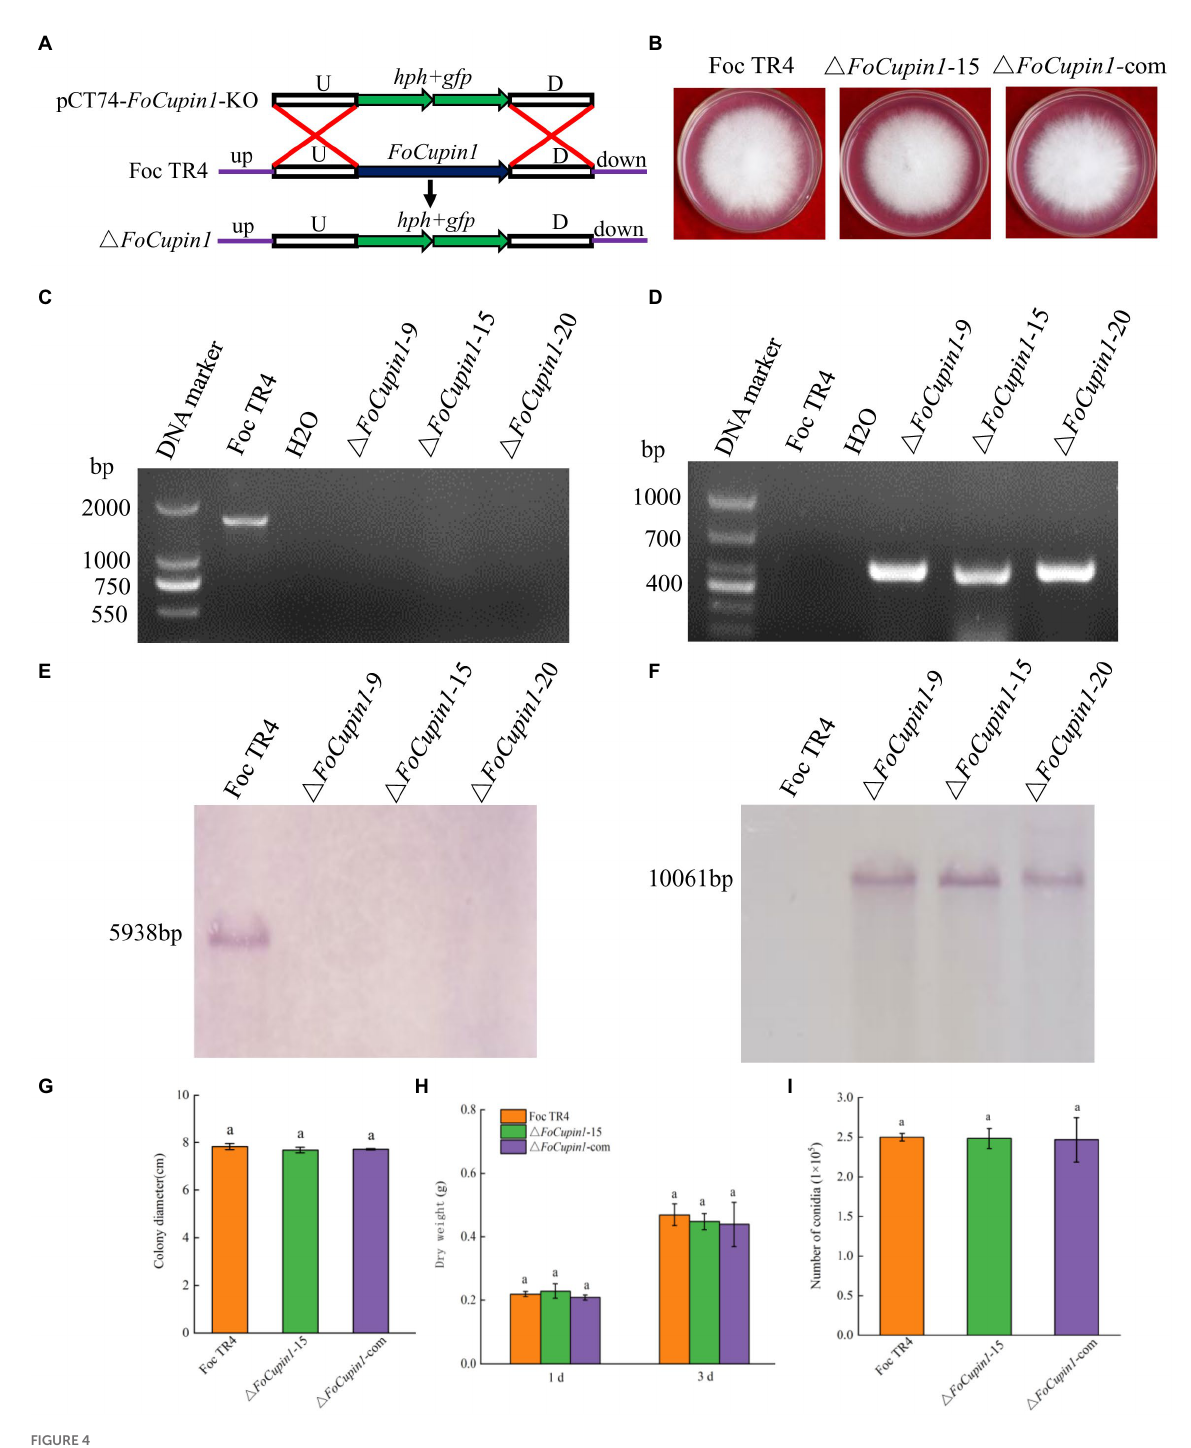
FIGURE 4 Construction, confirmation, and characterization of FoCupin1 deletion and complementation mutants. (A) Schematic strategy used for generation of the deletion mutant according to homologous recombination. U, upstream flanking region of FoCupin1 ; D, downstream flanking region of FoCupin1 . (B) Colony morphologies on PDA medium. Photos were taken 5 days after incubation. (C,D) PCR confirmation using FoCupin1 and hph as probes; (E,F) Southern blot validation using FoCupin1 and hph as probes, respectively. (G) Colony diameter. (H) Dry weight. Hyphae were collected from 1 and 3 days cultures grown in CM medium. (I) Conidiation. Foc TR4, the wide-type strain; FoCupin1-9, FoCupin1-15 and FoCupin1-20 , FoCupin1 deletion mutants; △ FoCupin1 -com, FoCupin1 complementation strain. Means and standard deviations were calculated from three independent experiments. Values on the bars followed by the same letter are not significantly different at p < 0.05 by Duncan’ s multiple range